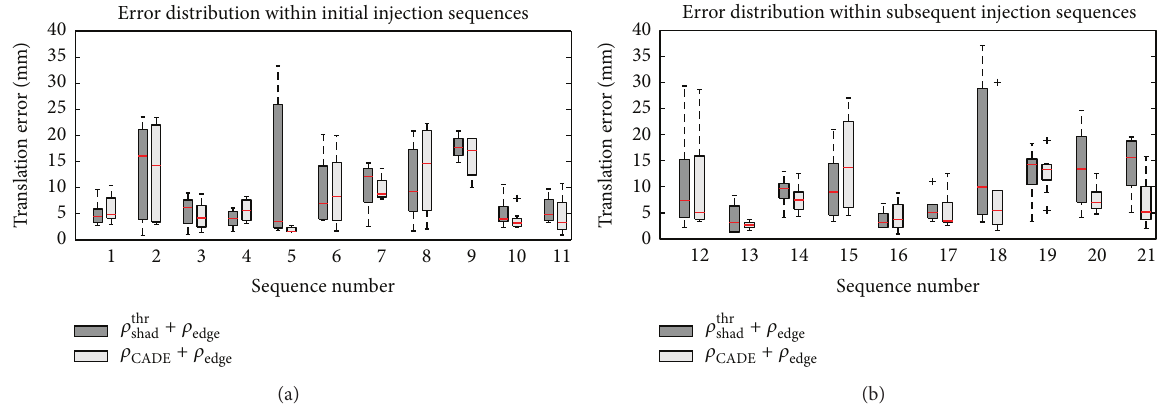
+ 𝜌 Figure 8: Distribution of the errors within each sequence. While there is no significant difference for initial injections (a), 𝜌 CADE edge + 𝜌 performs significantly better than 𝜌 thr for subsequent injections (b). Subsequent contrast injections are characterized by a smaller edge shad amount of contrast and the presence of more catheters making registration more difficult. Example images of sequence 1 are shown in Figures 2 and 3; example images of sequence 2 are shown in Figure 1(a). Here, contrast agent is very faint and in some frames contrasted is already + 𝜌 got confused by edges caused by motion artifacts. ejected into the left ventricle. Sequence 5 is shown in Figure 1(d). In this case, 𝜌 thr edge shad